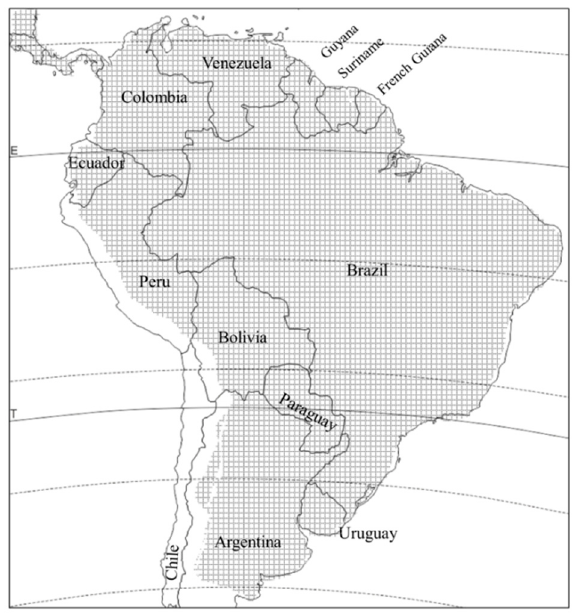
Figure 2. Distribution of Diabrotica speciosa in South America (crosshatched area). Table 1. Main crops attacked by the South American pest Diabrotica species, and current and potential control